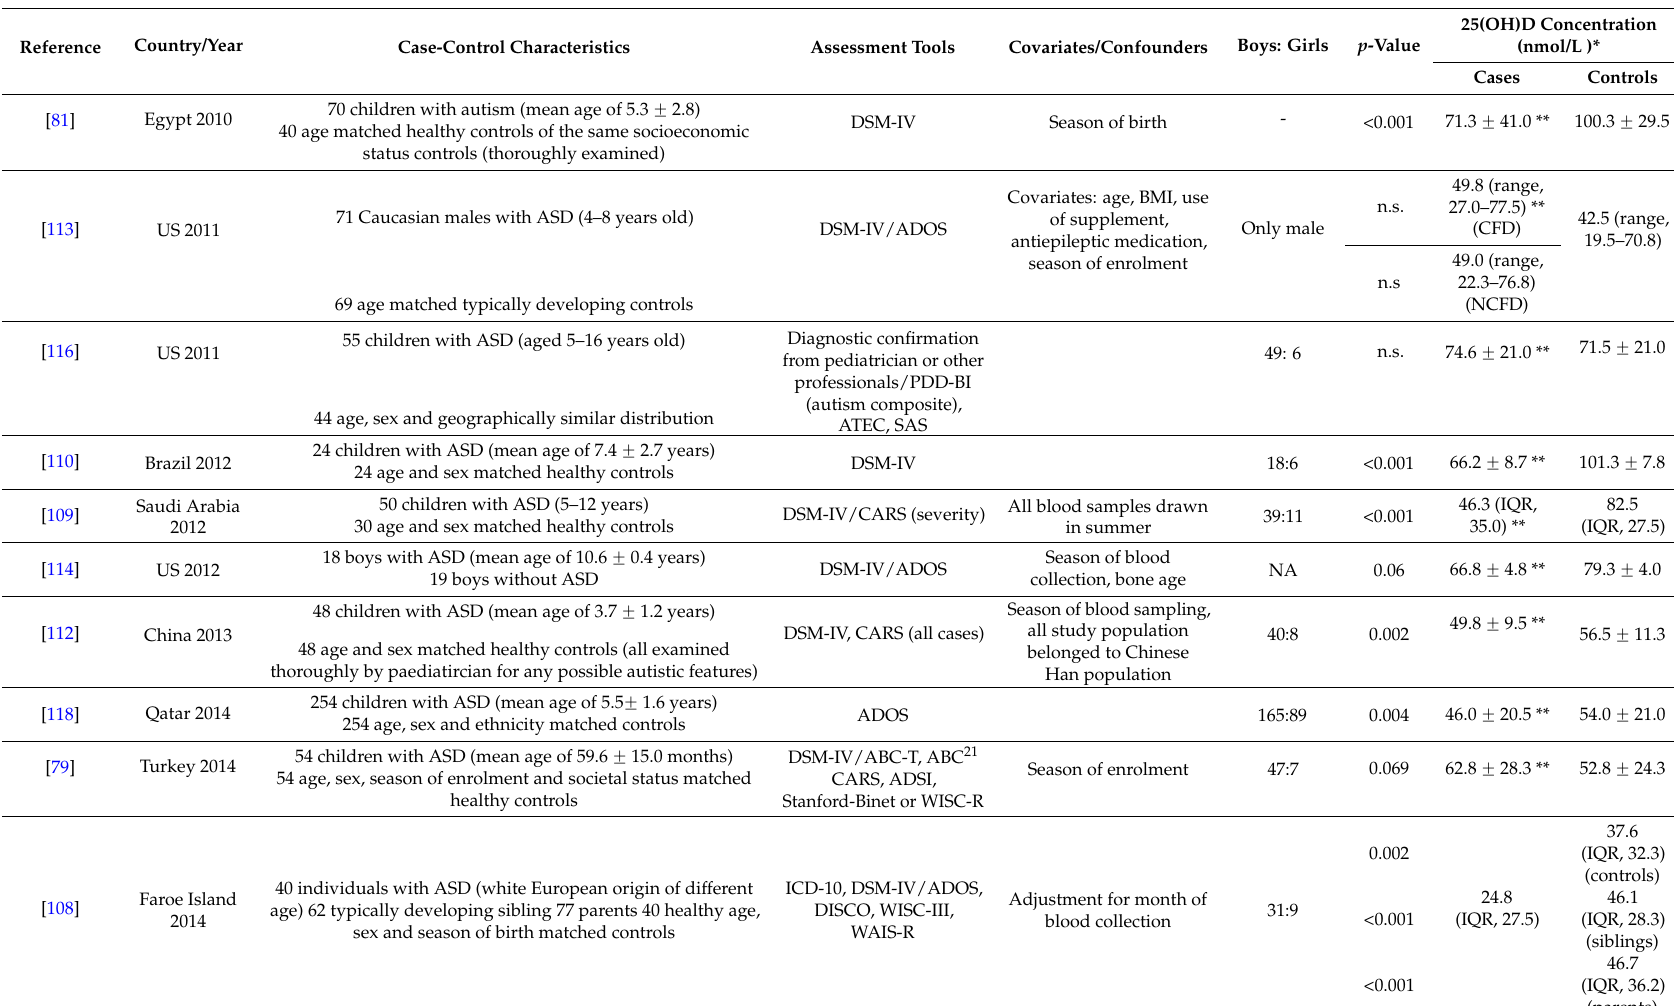
Table 5. Vitamin D status in ASD patients-Case-control